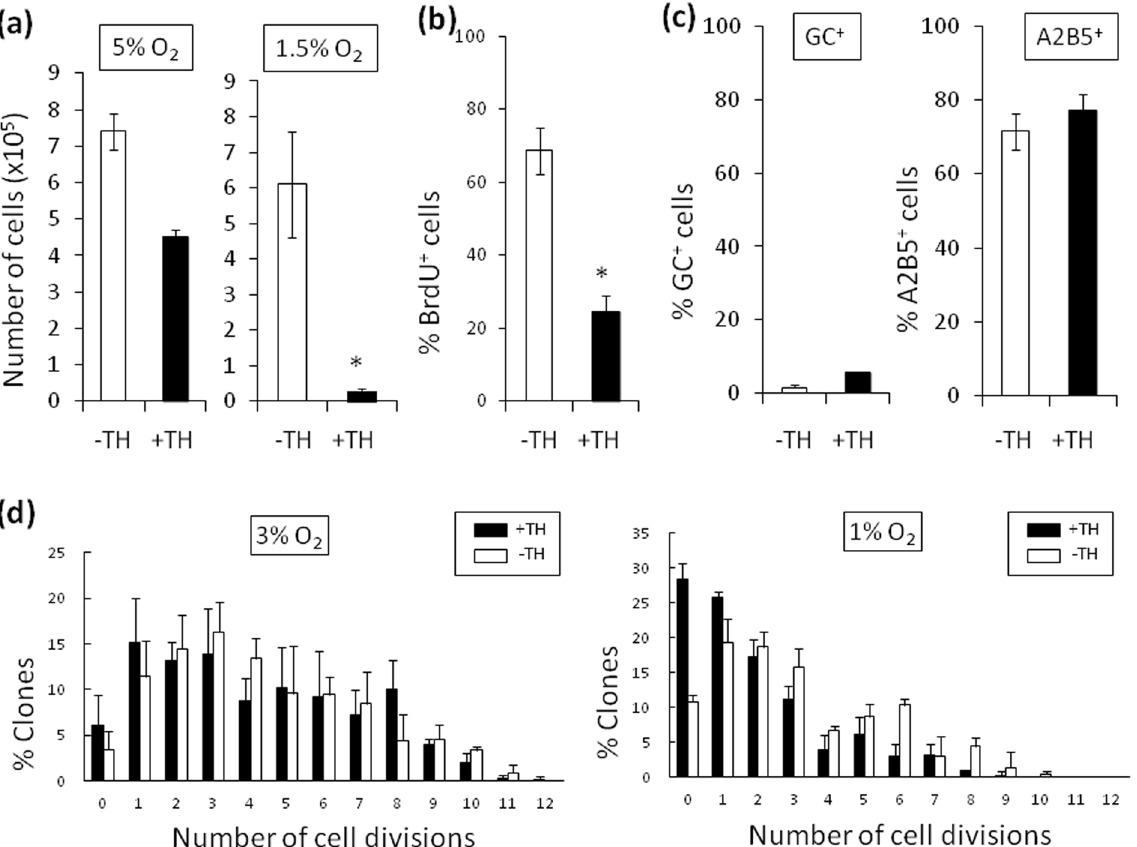
Figure 8. TH-dependent deceleration of cell cycle of OPCs purified from P7 rat cerebral cortex or P7 mouse optic nerve. Purification of OPCs from P7 rat cerebral cortex was carried out obeying Dugas et al . 47 . 2,000 of OPCs were cultured without TH ( − TH; white bars ) or with TH ( + TH; black bars ). ( a ) Cells were cultured in 5% O 2 or 1.5% O 2 . The numbers of cells were counted at day 11. 0.01 < * P < 0.02 (unpaired Student’s t -test, n = 3). ( b ) Cells cultured in 1.5% O 2 for 10 days were treated with BrdU for 20 hours and then labeled with anti- BrdU antibody and Hoechst 33342 dye, and the percentage of BrdU + cells was determined. * P < 0.01 (unpaired Student’s t -test, n = 3). ( c ) Cells were cultured in 1.5% O 2 for 11 days. They were then stained with the nuclear stain DAPI and a monoclonal anti-GC or A2B5 antibody, and the percentage of the DAPI + cells that were GC + or A2B5 + was determined (unpaired Student’s t -test, n = 3). Note that most of the cells cultured were remained OPC specific morphologies with GC − , A2B5 + . ( d ) OPCs were purified from P7 C57BL/6 mouse optic nerve by immunopanning according to Watkins et al . 48 and cultured at clonal-density according to Durand et al . 64 . The cells were cultured for 12 days in PDGF, with TH ( black bars ) or without TH ( white bars ), in either 3% or 1% O 2 . The number of cell divisions was estimated from the cell numbers in each clone (n =